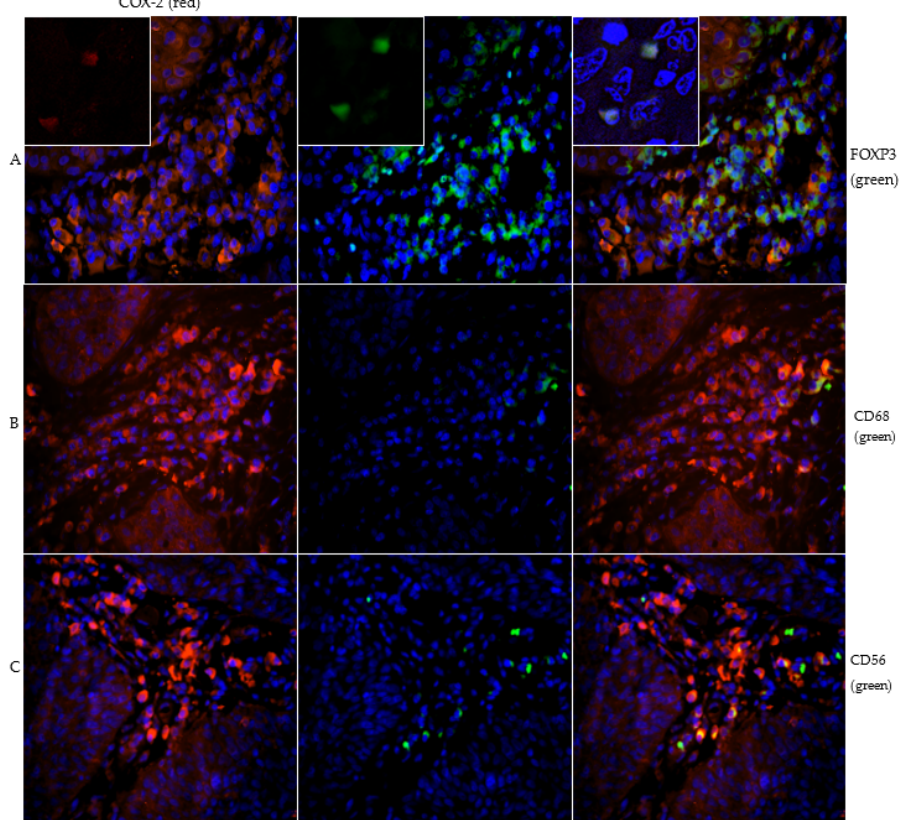
Figure 2. Image series ( A ) demonstrates the double staining of COX-2 (red) and FOXP3 (green) with inserts of magnification 40× to show nuclear staining of FOXP3. The majority of COX-2 positive immune cells peritumorally are FOXP3 positive and thus detected as Treg cells. Image series ( B ) presents the double staining of COX-2 (red) and CD68 (green). The subtyping shows that some macrophages are COX-2 positive. Figure series ( C ) shows the double staining of COX-2 (red) and CD56 (green). The CD56 positive NK cells are weakly pronounced and only singly distributed in the stroma.